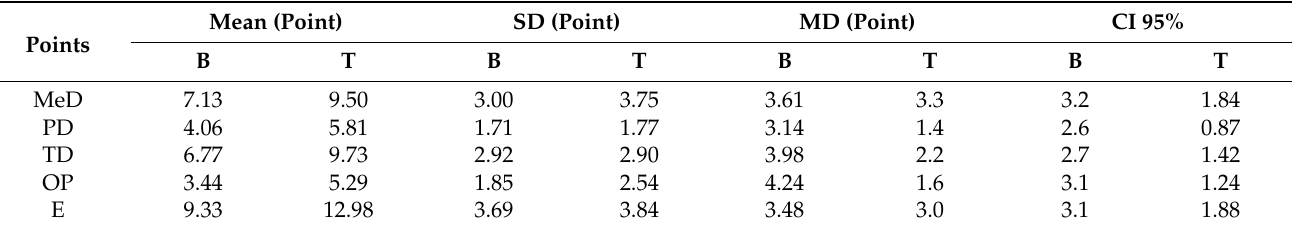
Table 11. NASA-TLX statistical